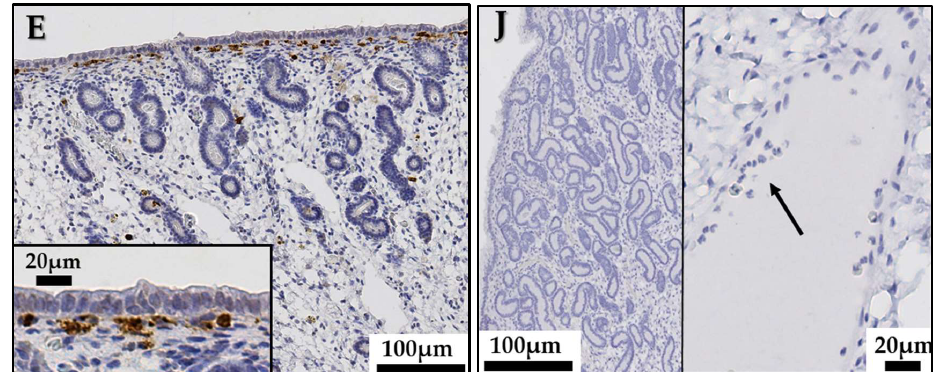
Figure 4. Immunohistochemistry. Equine endometrial myeloperoxidase (MPO) expression during the estrus cycle and seasonal anestrus. Images represent endometrial tissue samples from different mares in estrus ( A – D ), anestrus ( E ) and diestrus ( F – I ). Estrus: ( A ) Endometrial epithelial cells show a generalized MPO expression. The staining intensity in glandular cells increases with depth. Mag- nification 10×. ( B ) The adluminal epithelium shows a generalized intracytoplasmic diffuse mosaic- like staining reaction (thick arrow). A uniform intracytoplasmic pattern expression is observed in stromal cells (thin arrows). Magnification 20×. ( C ) Middle and basal uterine glands show a uniform, predominantly apical (arrow), intracytoplasmic diffuse pattern expression. Magnification 20×. ( D ) In presence of neutrophils in sub and transepithelial areas, the adluminal epithelium shows a uni- form intracytoplasmic diffuse staining reaction (arrow). Magnification 20×. Anestrus: ( E ) Glandular endometrial cells are immunonegative. Magnification 10×. Inset: the luminal epithelium shows no or only a residual staining. Neutrophils in sub-epithelial capillaries are positively stained. Magnifi- cation 40×. Diestrus: ( F ) The epithelial cells immunostaining is not generalized. Magnification 10×. ( G ) The adluminal epithelium is irregularly marked. An intracytoplasmic diffuse mosaic-like stain- ing reaction is observed in immunopositive areas (thick arrow) near immunonegative areas (thin arrow). Magnification 20×. ( H ) Endometrial glands show a sporadic MPO immunostaining (arrow). Magnification 20×. ( I ): Some basal glands show a nuclear immunostaining of individual cells some- times accompanied by an intracytoplasmic diffuse staining. Magnification 20×. ( J ) Negative control showing no MPO in endometrial epithelial cells (left image, magnification 10×); and in neutrophils (right image, arrow, magnification 40×).